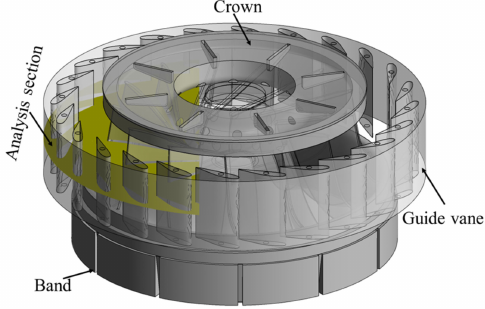
Figure 11. Schematic diagram of analysis